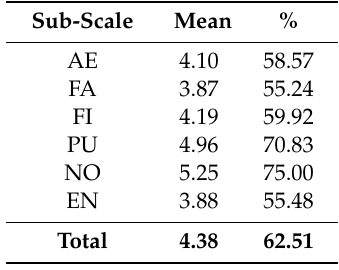
Table 3. UES sub-scales (percentage).